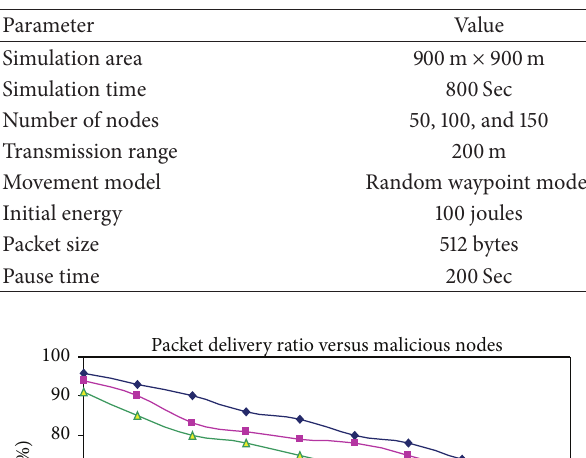
Table 1: Simulation parameters.